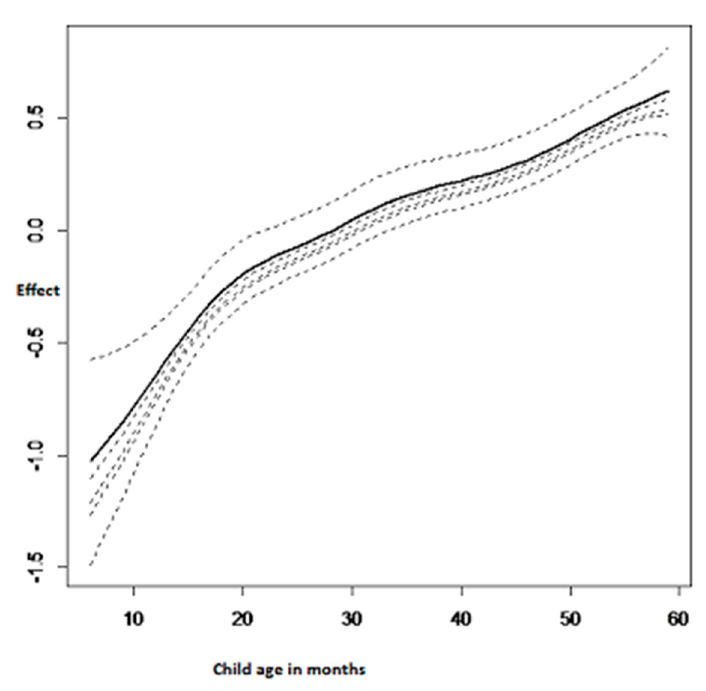
Figure 2. Nonlinear effects of the child’s age on adjusted childhood hemoglobin concentration.